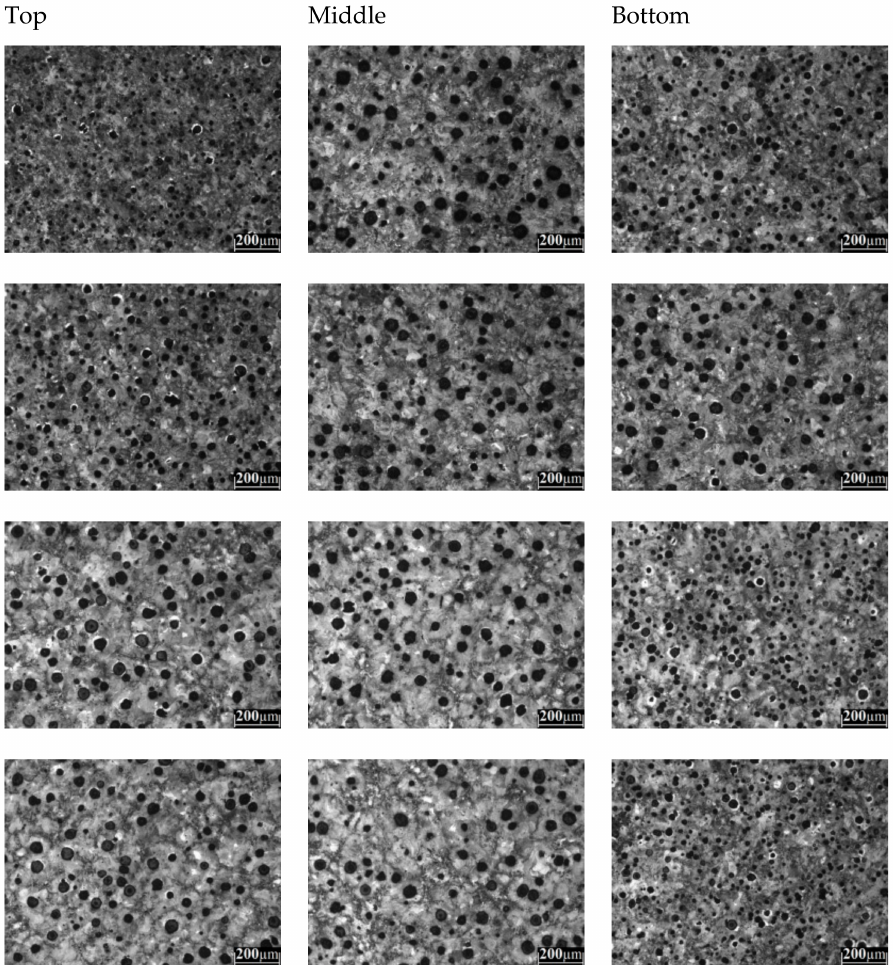
Figure A4. Etched microstructure of the ductile iron alloyed with 0.3 wt % V for different lobes and